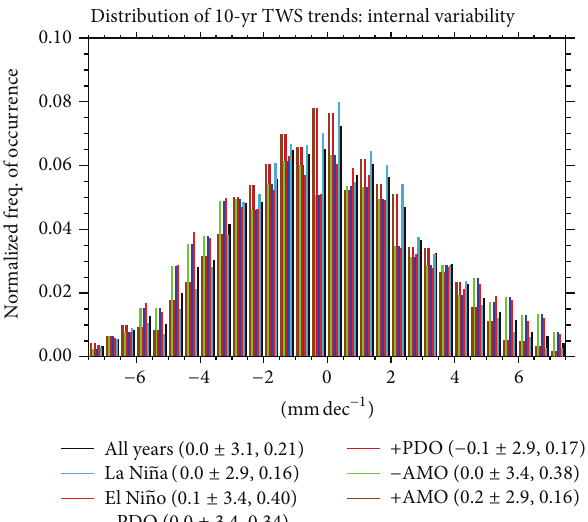
Figure 7: Normalized distribution of frequency of occurrence of decadal trends in TWS arising from internal variability (forced response removed) from 1920 to 2100. Also, indicated are the mean and standard deviation and skewness across trends.